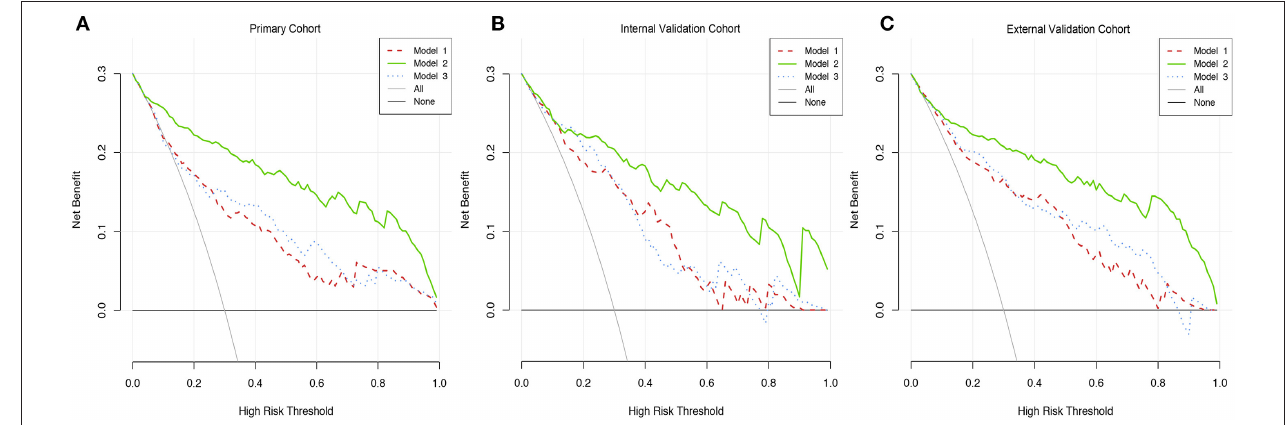
FIGURE 4 | Decision curve analysis of three prediction models. (A) The DCA curves of three prediction models in primary cohort. (B) The DCA curves of three prediction models in internal validation cohort. (C) The DCA curves of three prediction models in primary cohort in external cohort.